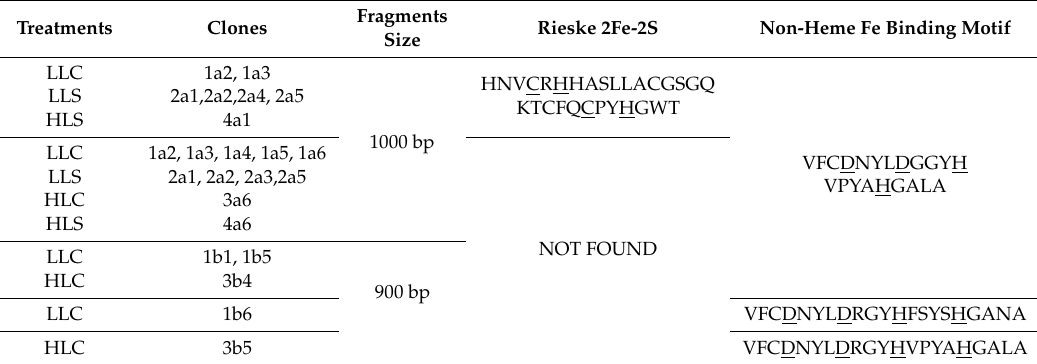
Table 1. Clones showing the presenceof intact conserved domains. LLC, control plants; LLS, salt stressed plants; HLC, high light stressed plant; HLS, light and salt stressed plants. Amino acids involved in binding domain are underlined.